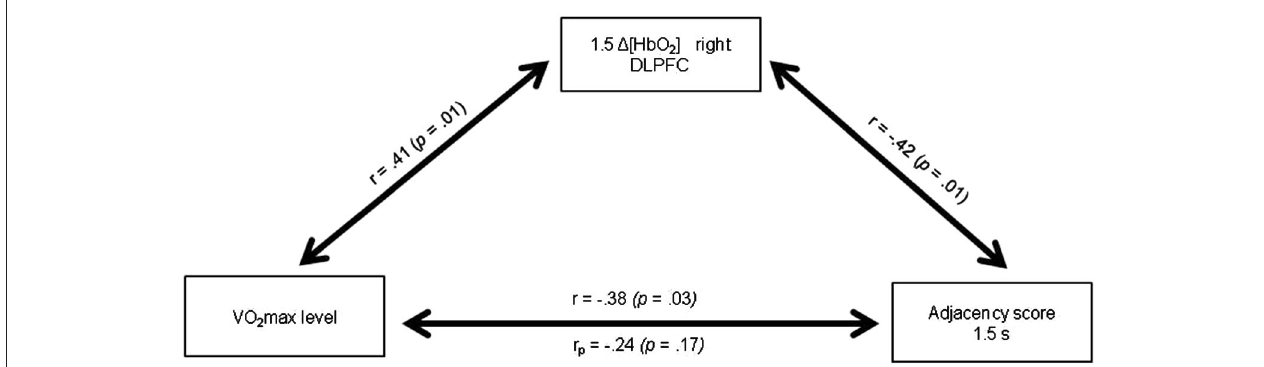
FIGURE 5 | Relationships between the VO 2 max level, the ∆ [HbO 2 ] slope coefficient in the right DLPFC during the 1.5 s RNG task and the Adjacency score at 1.5 s . r p : partial correlation after controlling for the 1.5 ∆ [HbO 2 ] slope coefficient in the right